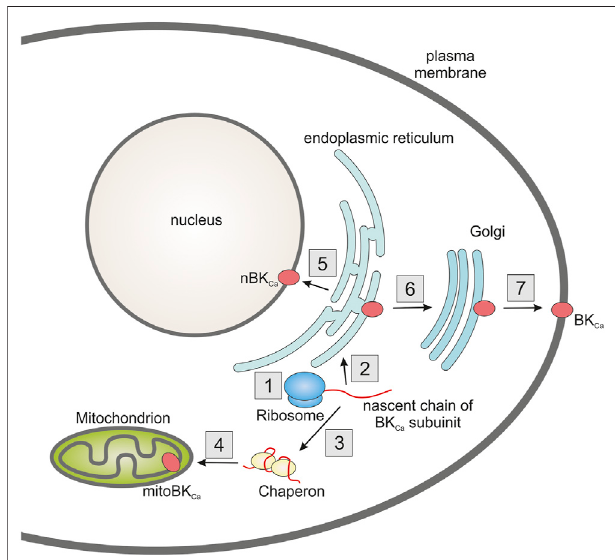
FIGURE 2 | Diagram showing the problem of targeting potassium channels to multiple cell compartments using the example of a BK Ca channel. The nascent pore forming subunit of the channel (1) can be targeted to the endoplasmic reticulum as its primary destination (2). A certain fraction of the protein, possibly using chaperones (3), can be directed to the mitochondria (4). From the endoplasmic reticulum, protein can be directed to other cell compartments such as the nucleus (5) or via the Golgi apparatus (6) to the plasma membrane (7). Probably the target location of the protein may also be in fl uenced by the translation rate, which may be in fl uenced by the codon usagebias(1).Inaddition, animportantroleinproteintargeting maybe played by alternative splicing, which results in the formation of various isoforms containing the appropriate targeting